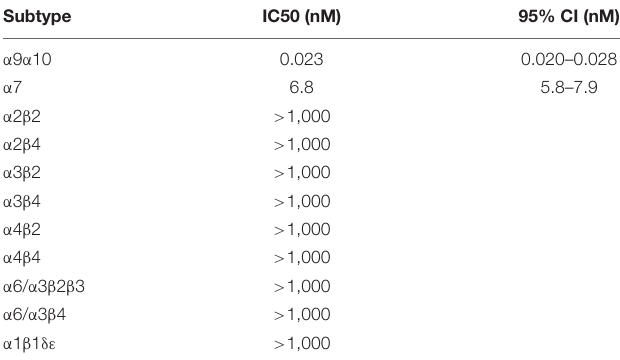
TABLE 1 | Cy3-RgIA-5727 IC 50 on Xenopus oocytes expressing